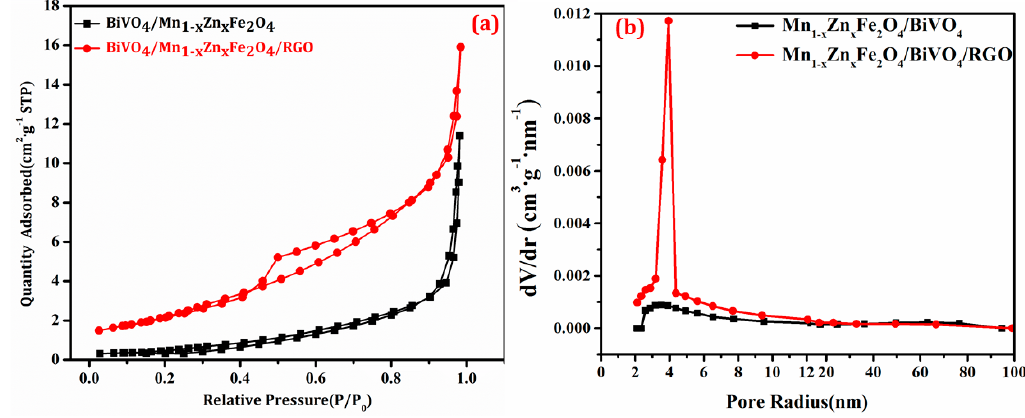
Figure 5. The adsorption–desorption isotherms of compounds ( a ), and the pore size distribution curves of compounds ( b ).